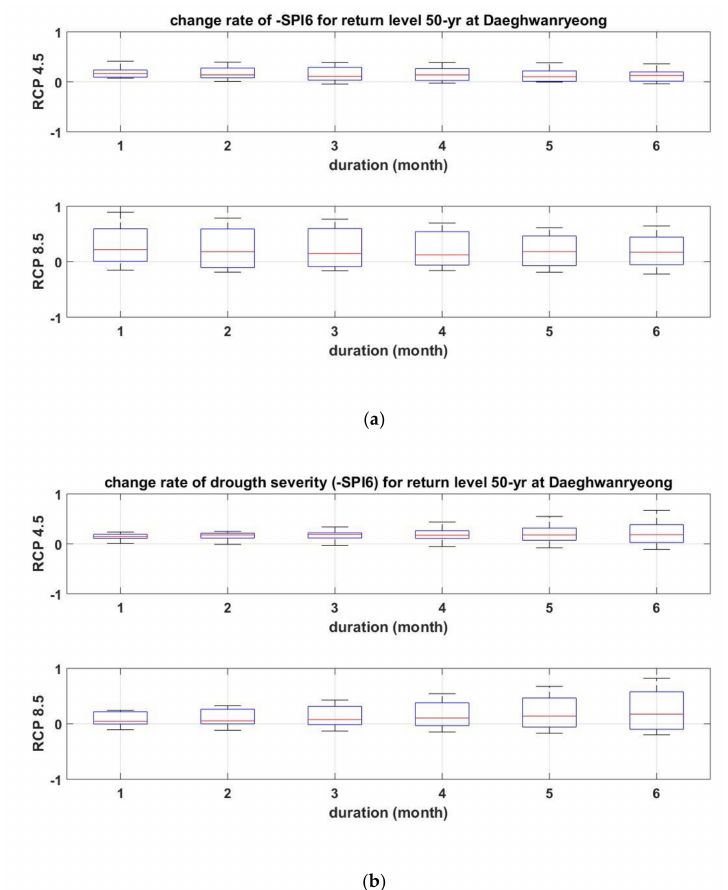
Figure 10. Change rate of drought severity for a return level of 50 years at the Daeghwanryeong site using ( a ) PDS approach, and ( b ) BED